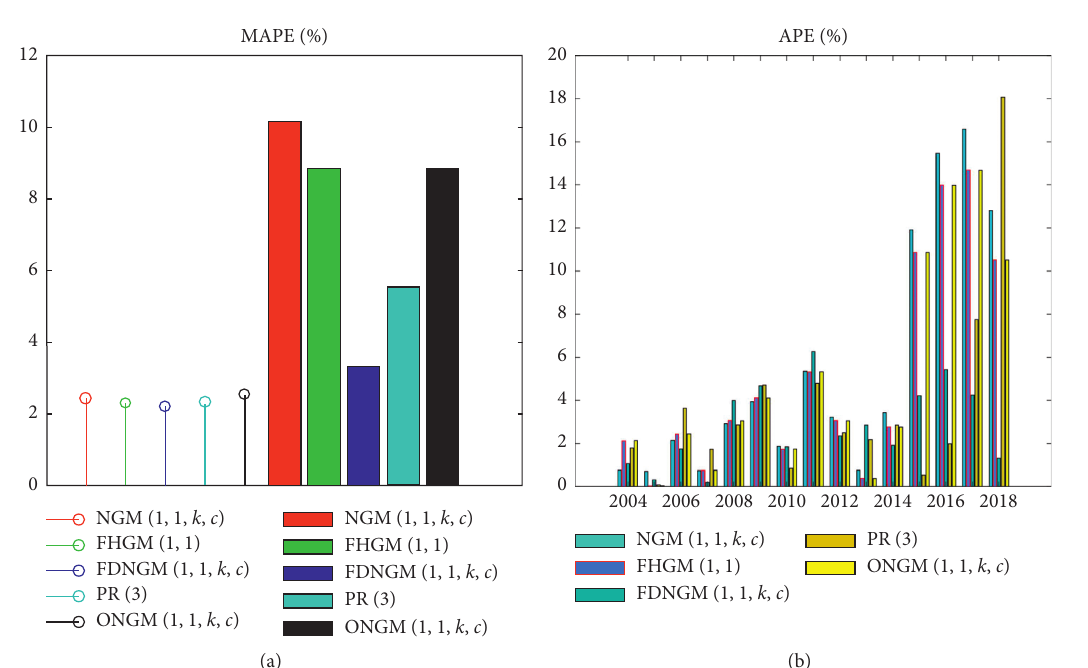
Figure 3: APEs and MAPEs of the competitive models in Case